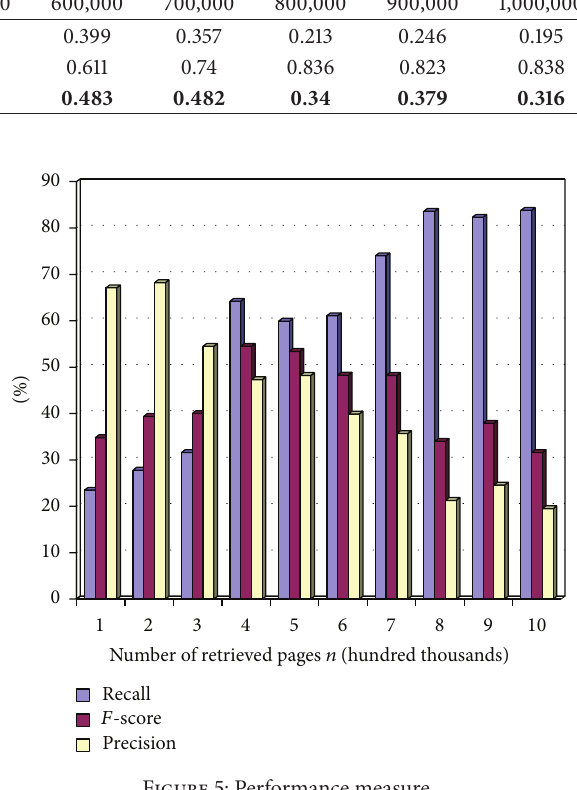
Figure 5: Performance